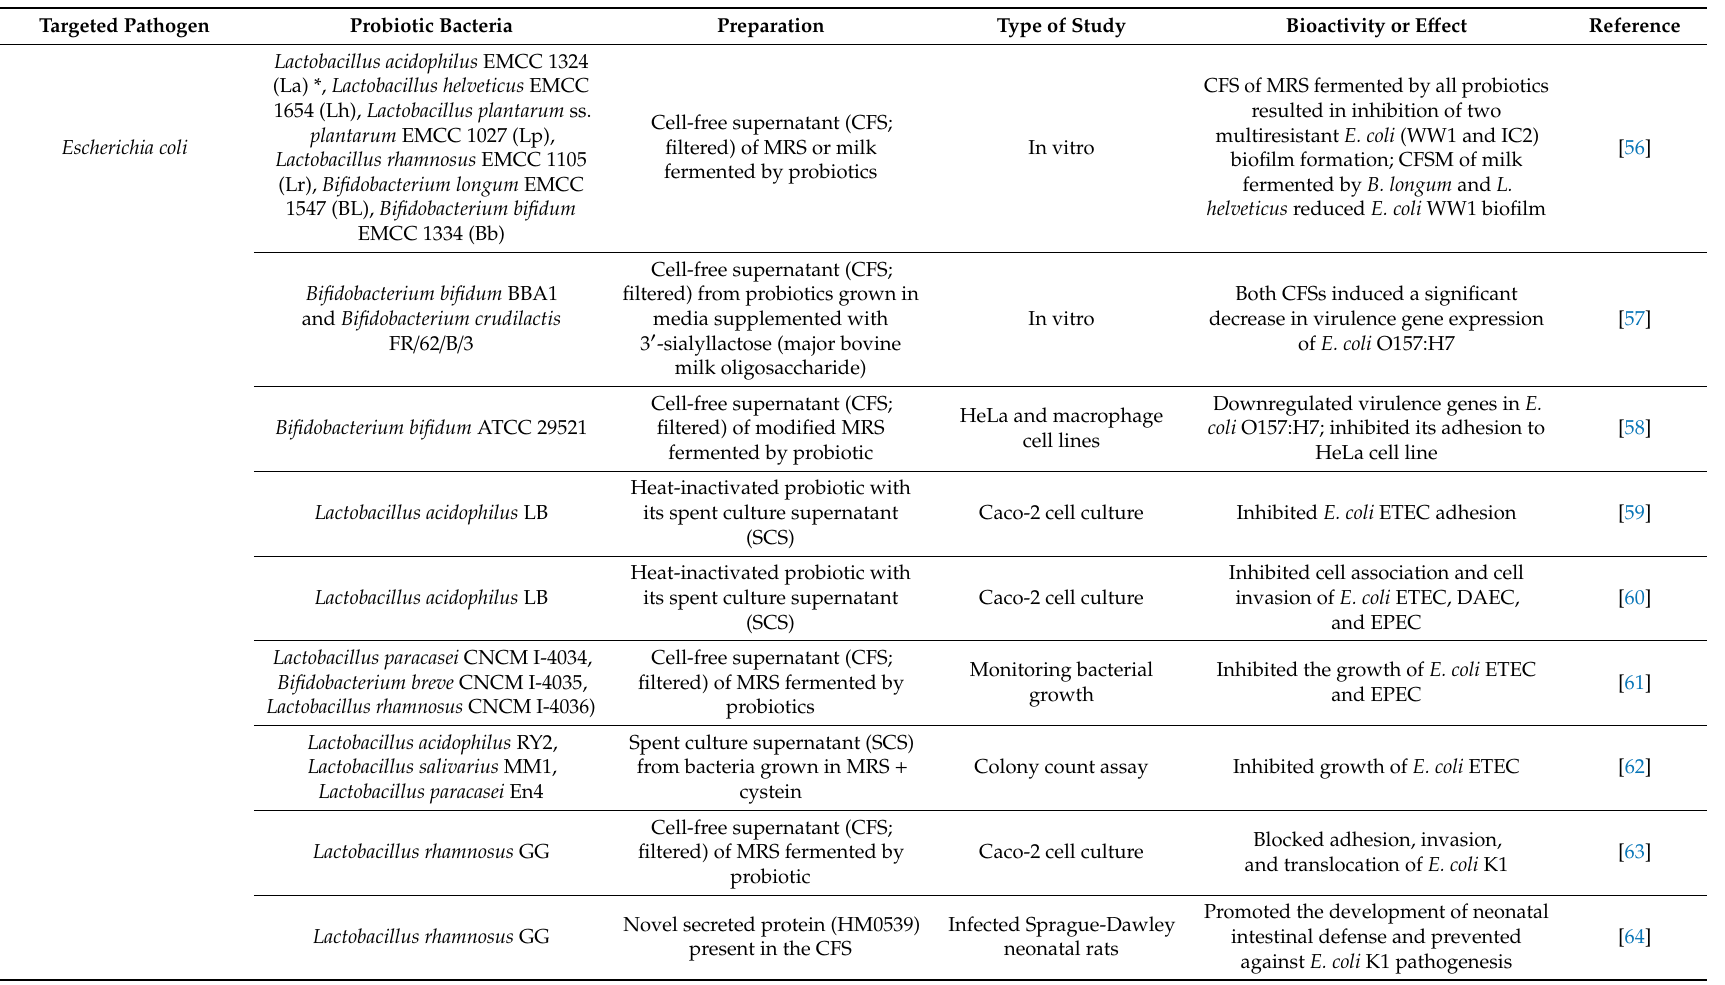
Table 1. Potential infectious disease targets for postbiotics based on current